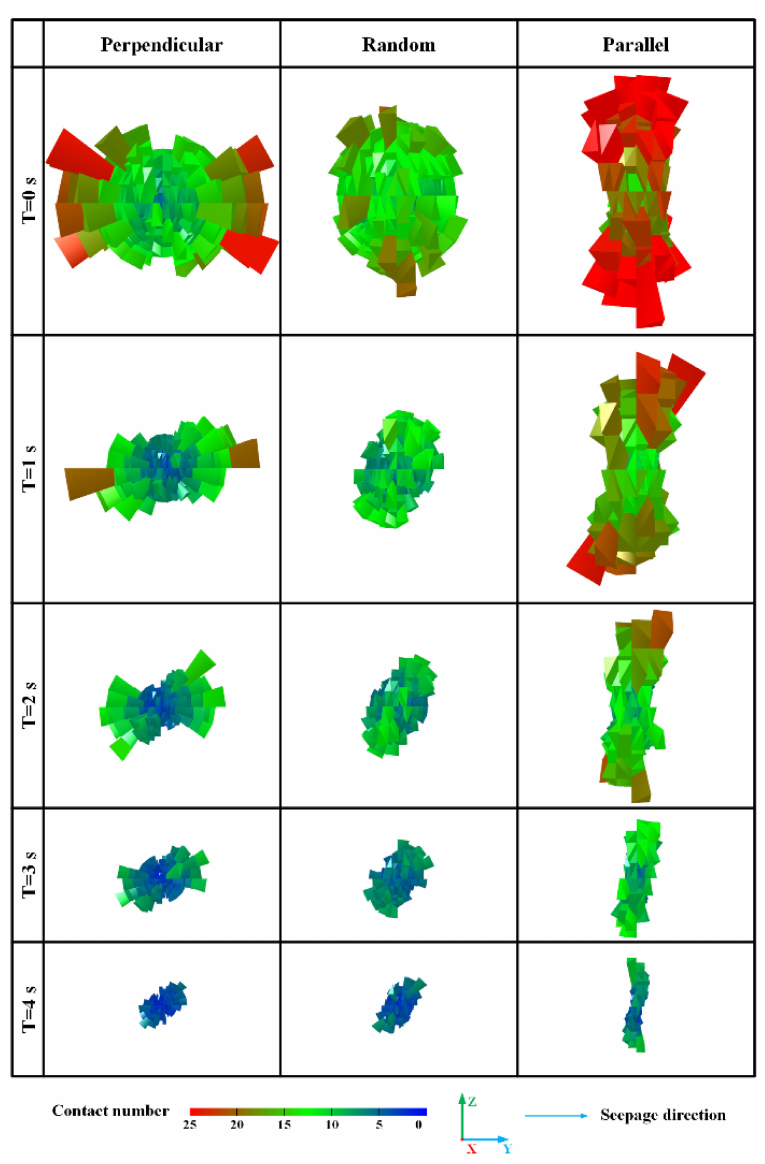
Figure 14. Three-dimensional fabric evolution of fiber-sand contacts for these three